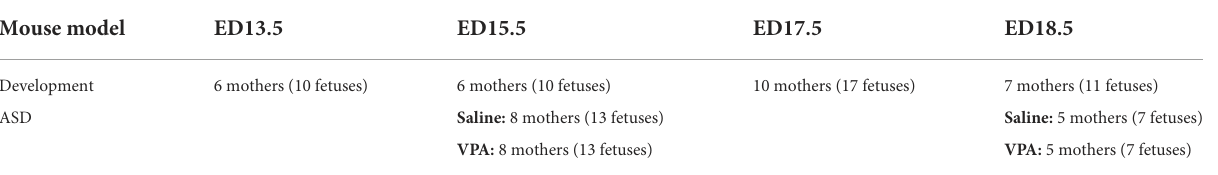
TABLE 1 Summary of sample